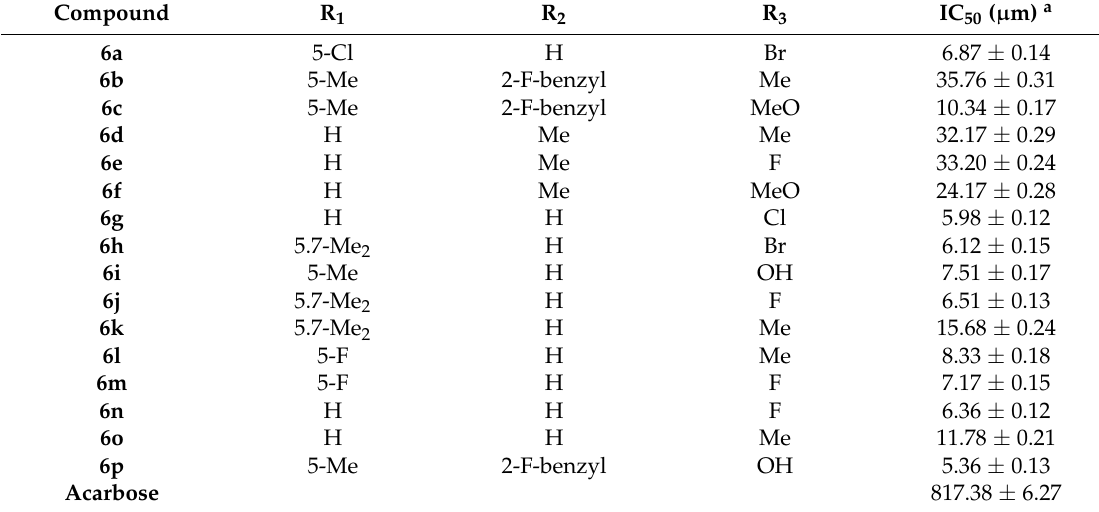
Table 1. α -Glucosidase inhibitory activity of novel isatin-thiazole derivatives ( 6a – 6p ).